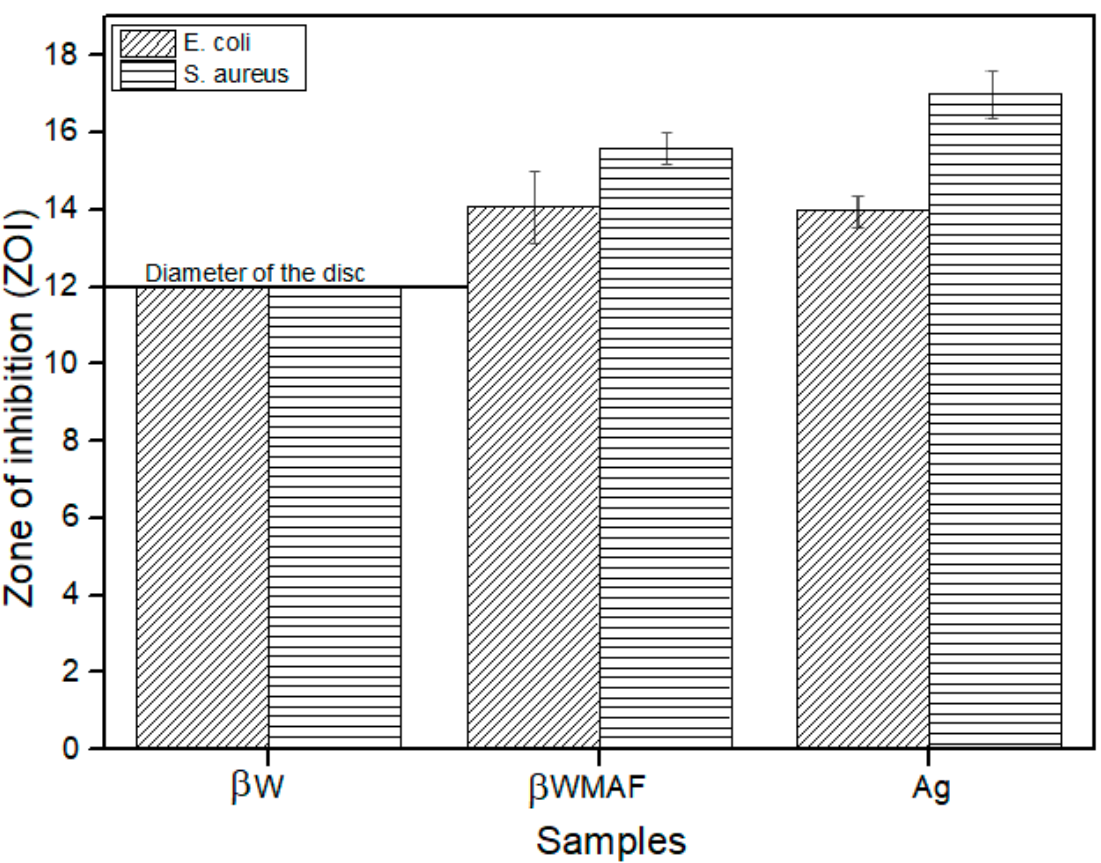
Figure 10. Zone of inhibition (ZOI) of the β W (negative control), β WMAF, and Ag (positive control) disc samples after 24 h.